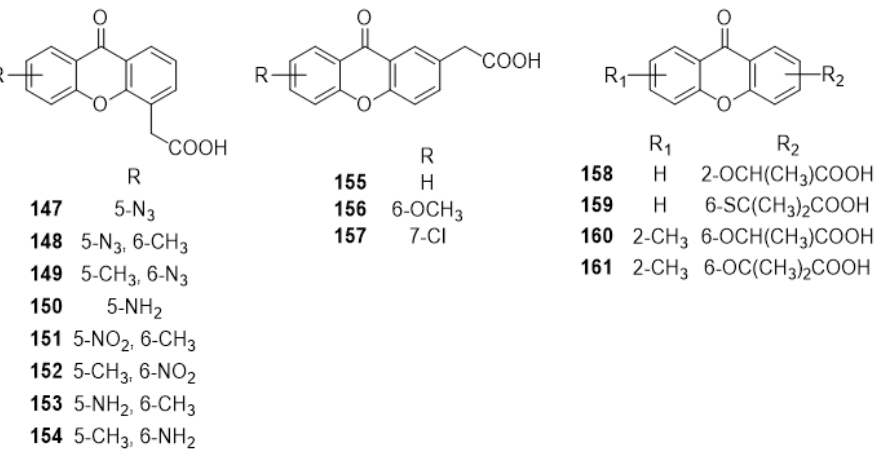
Figure 11. Structures of DMXAA analogues 147 – 161 .